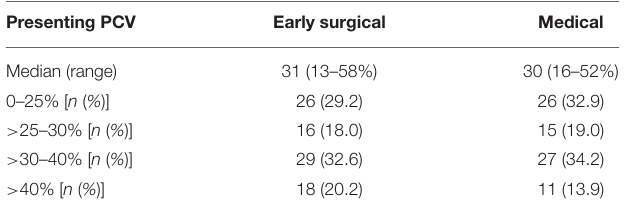
TABLE 2 | Presenting PCV between “early surgical” ( n = 89) and “medical” ( n = 79) groups. Presenting PCV Early surgical